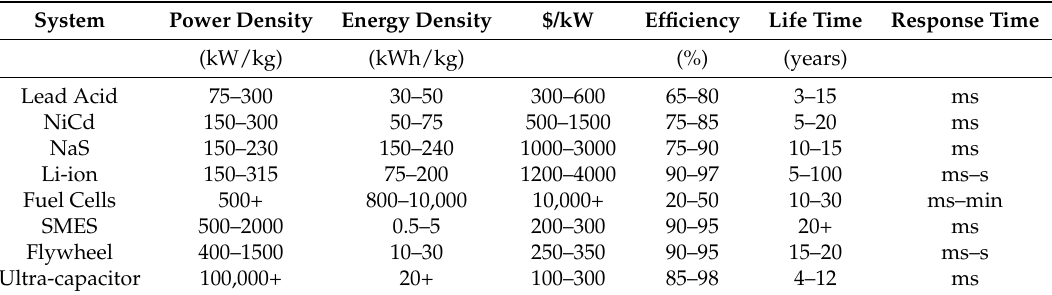
Table 1. Technical features of ESS [15,16,24,25].